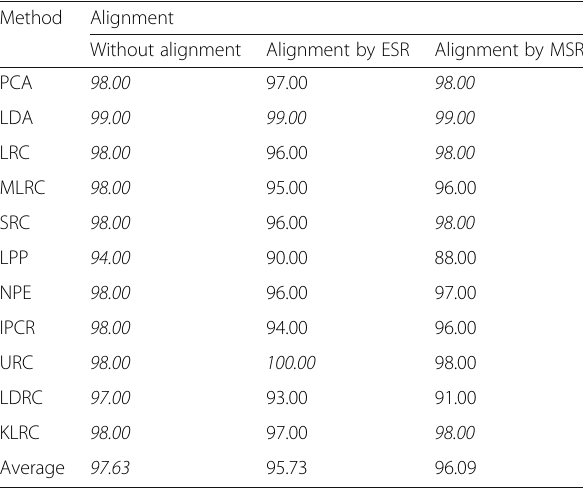
Table 7 Recognition performances (%) on FRGC database (normal faces) Method Alignment Without alignment Alignment by